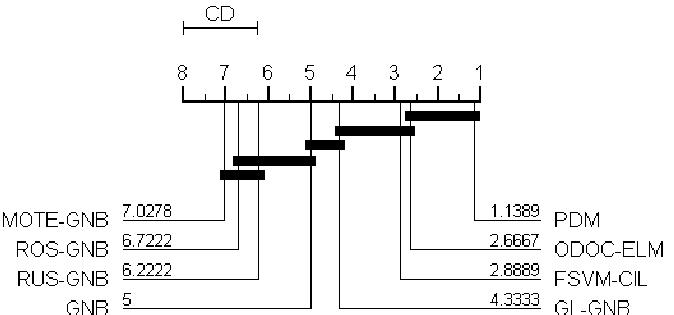
Figure 7. CD diagram.